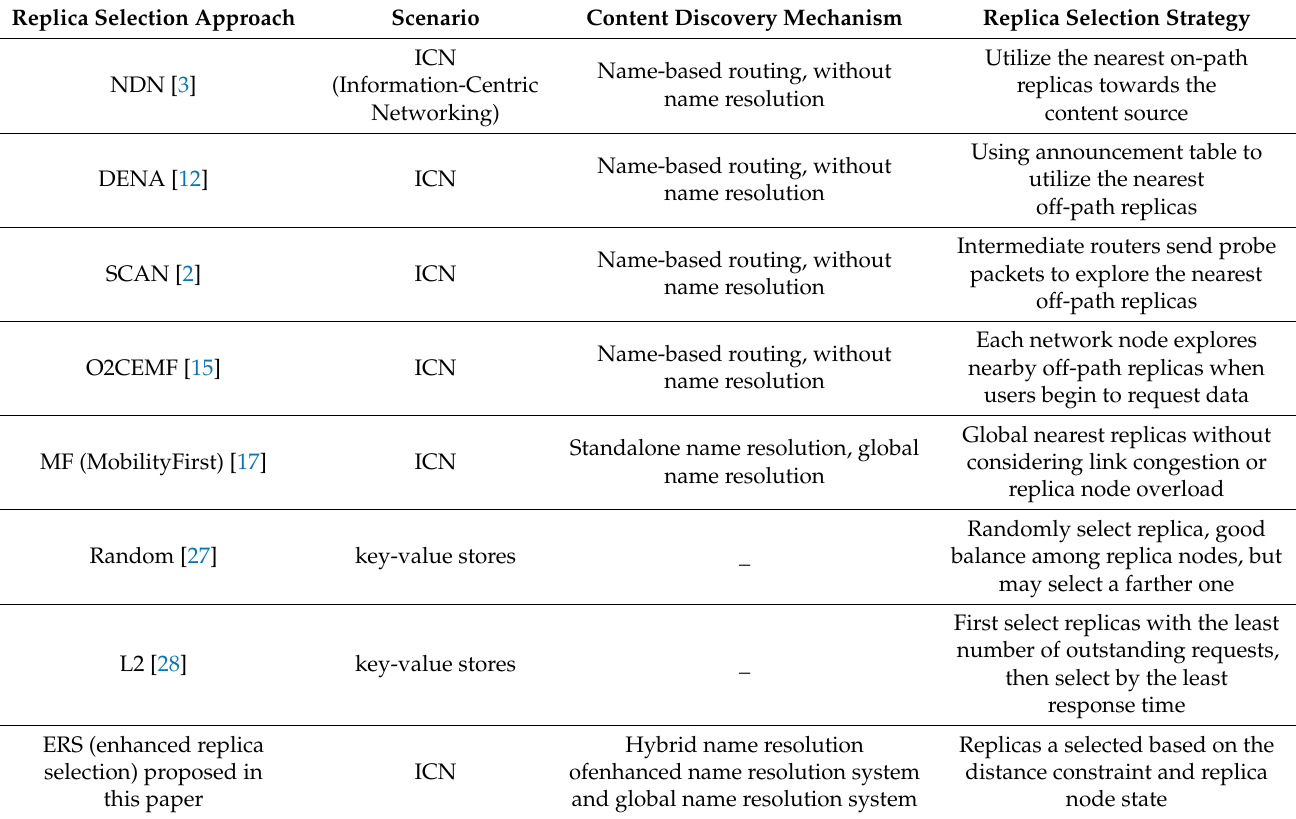
Table 1. Summary of the replica selection approaches in the